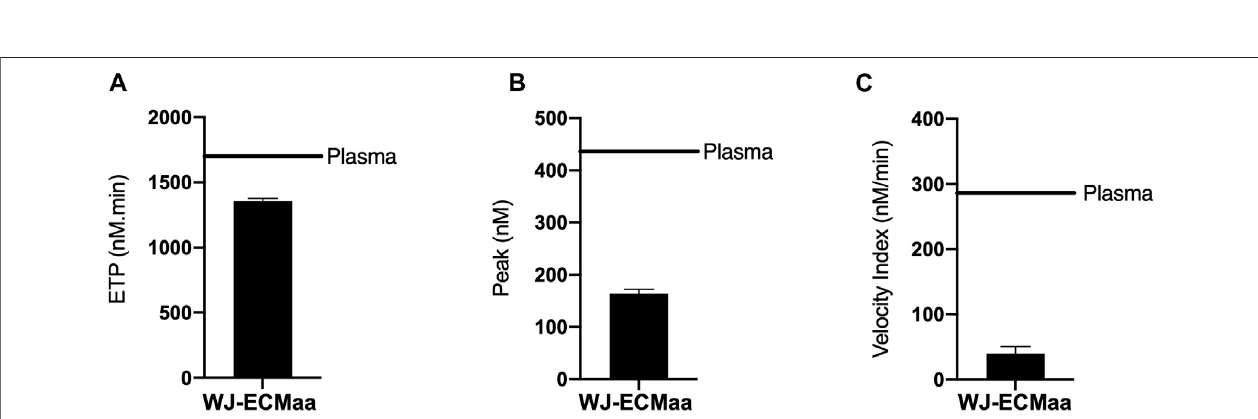
FIGURE 6 | Thrombogenicity evaluation of the WJ-ECMaa coating monitored by thrombin generation assay. (A) ETP: endogenous thrombin potential, a re fl ection of the thrombogenic potential of the sample ; (B) Peak: maximum value of active thrombin generated with the sample; (C) Velocity index: re fl ecting the slope of the explosive thrombin generation. Results presented as mean ±